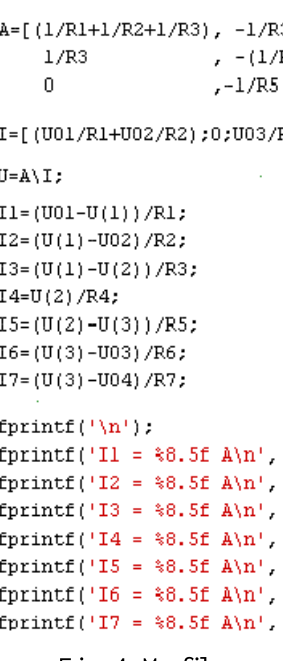
Fig. 4. M-file prudy.m for calculation of matrices and